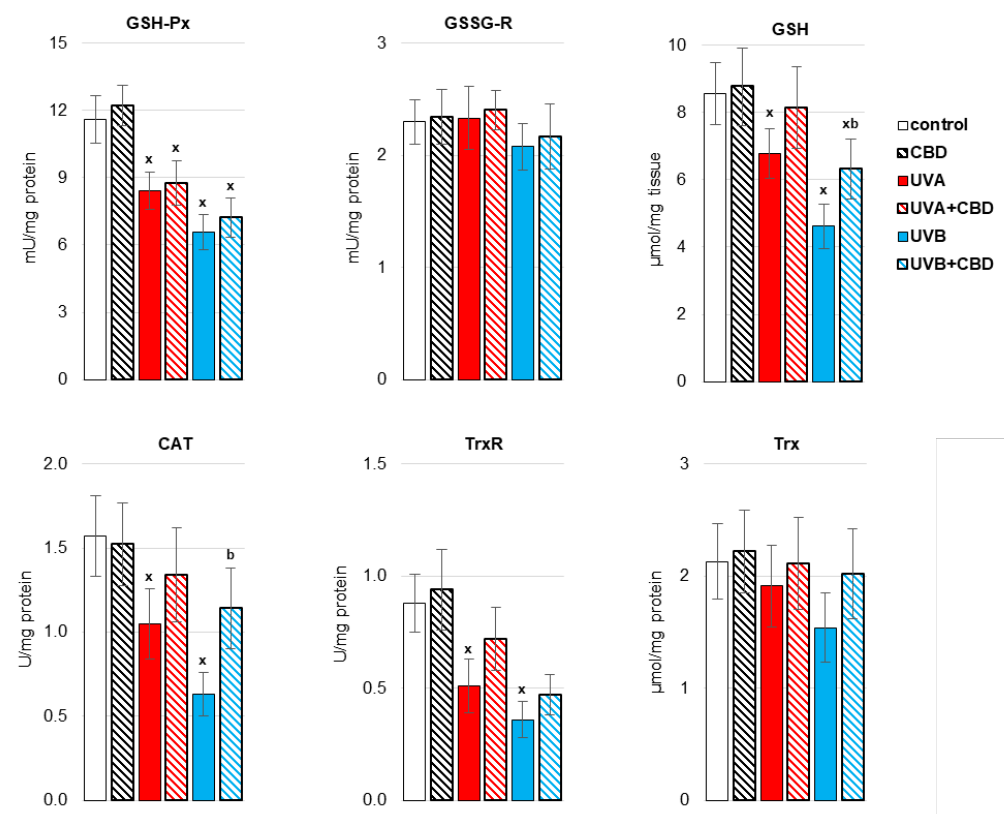
Figure 2. The activity of antioxidant enzymes [glutathione peroxidase (GSH-Px), glutathione reductase GSSG-R), catalase (CAT), thioredoxin reductase (TrxR)] and the level of glutathione (GSH) and thioredoxin (Trx) in the liver of nude rats in the following groups: treated with CBD (every 12 h) for 4 weeks; irradiated with UVA (every 48 h) and treated with CBD (every 12 h) for 4 weeks; irradiated with UVB (every 48 h) and treated with CBD (every 12 h) for 4 weeks. The mean values for six rats in each group ± SD are shown: x—differences vs. control group, p < 0.05; b—differences vs. UVB treated group, p < 0.05.